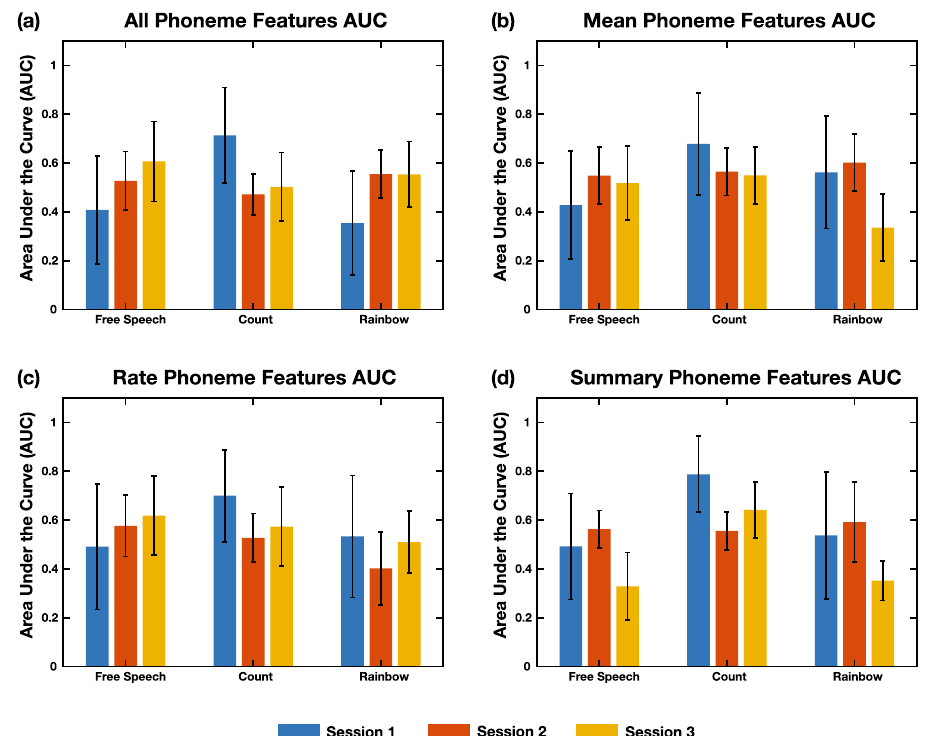
Figure 4. Model performance utilizing phoneme-based features. ( a ) AUC scores from models created using all phoneme-based features. The different bars in each task represent which of the recording days was used in the test data set. Statistics show that the phoneme based features generally don’t seem to outperform the univariate statistics. ( b ) AUC scores from models created using the means of the phoneme durations. Overall, these features used to train a model seem to perform similarly to using all of the phoneme based features across all days. ( c ) AUC scores from models created using the rates of the phonemes. The rate features seem to perform similarly to using all of the phoneme based features and just using the means of the phoneme durations. ( d ) AUC scores from models created using a set of six summary statistics of the phoneme based features. Features derived from most of the tasks seem to perform similarly to the other sets of features selected for model creation. Error bars are the standard deviation of the statistic across all bootstrap